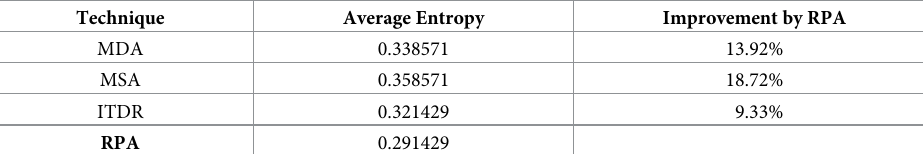
Table 17. Average percentage improvement of entropy by RPA